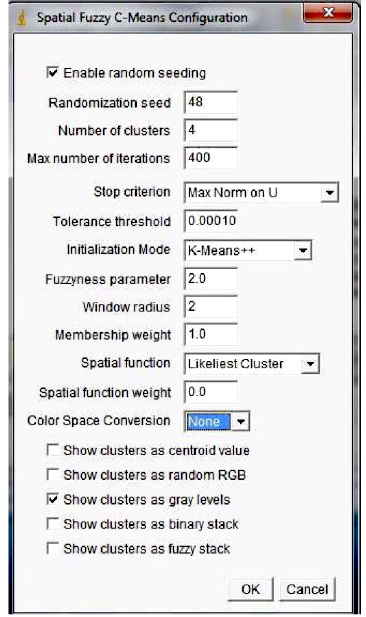
Figure 1. Graphical interface for the selection of Spatial FCM (SFCM)